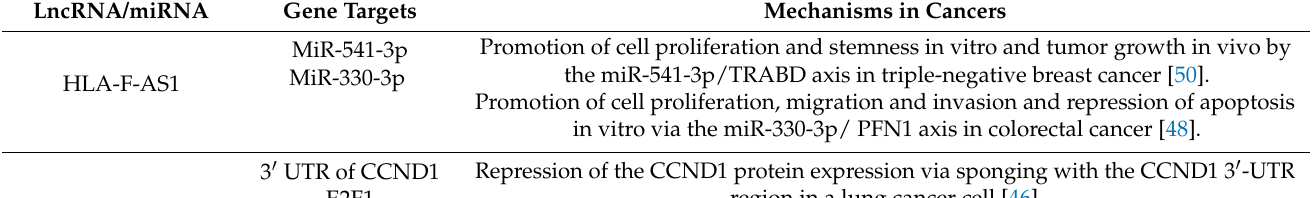
Table 1. Summary of the roles and mechanisms of discussed lncRNAs and miRNAs in the pathogenesis of cancers. LncRNA/miRNA Gene Targets Mechanisms in Cancers MiR-541-3p HLA-F-AS1